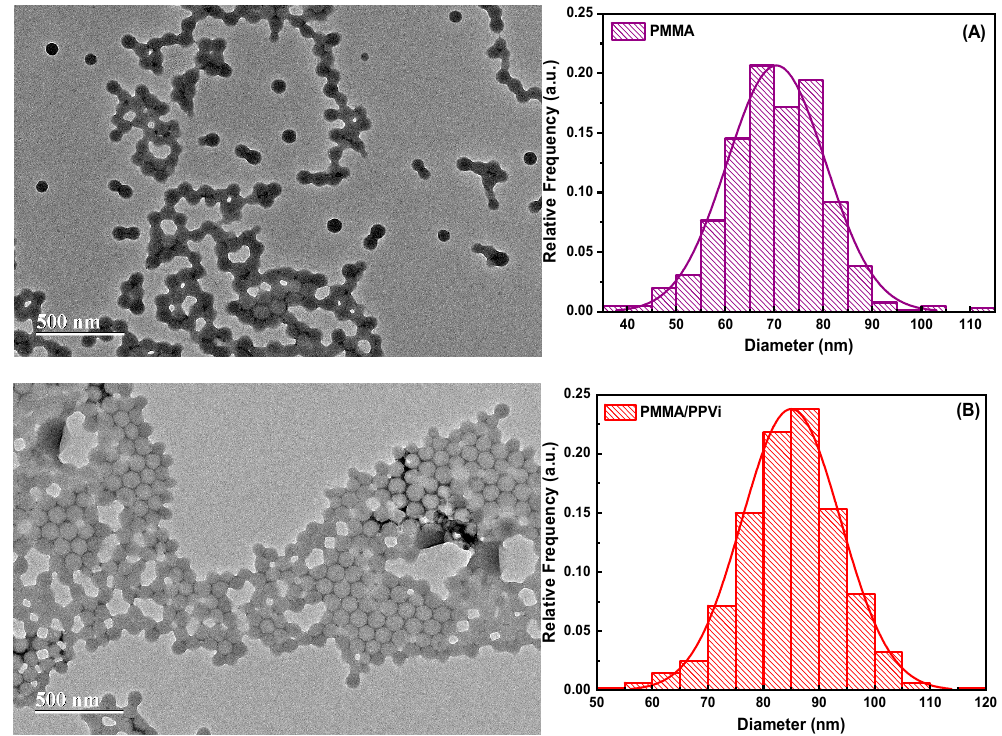
Figure 3. Micrographs from TEM measurements and histogram of particle size distribution ( A ) PMMA homopolymer and ( B ) PMMA/PVPi core–shell nanoparticles.